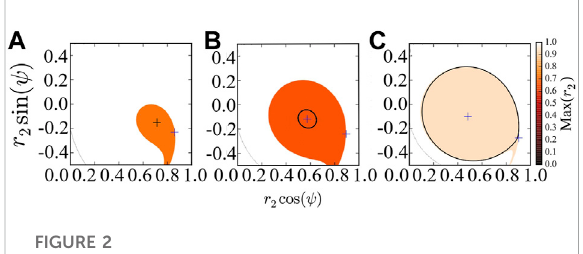
Basins of attraction of chimera states of the reduced system Eq. 7, which are colored with respect to the maximum value Max ( r (A) The system converges to the stable chimera (denoted 2 ). by black plus). (B) The system converges to the breathing chimera(denotedbyblackcircle). (C) Thesystemconvergestothe long-period breathing chimera (denoted by black circle). In (A – C) , we regard r 2 and ψ as polar coordinates, and the blue pluses indicate the location of fi xed points. For the simulation, the initial values ( r 2 , ψ ) = (0.7, − 0.1) are inside the basin of attraction of chimerastates, andwe fi x β =0.1andvary A =0.20 (A) , A =0.28 (B) and A = 0.35 (C)